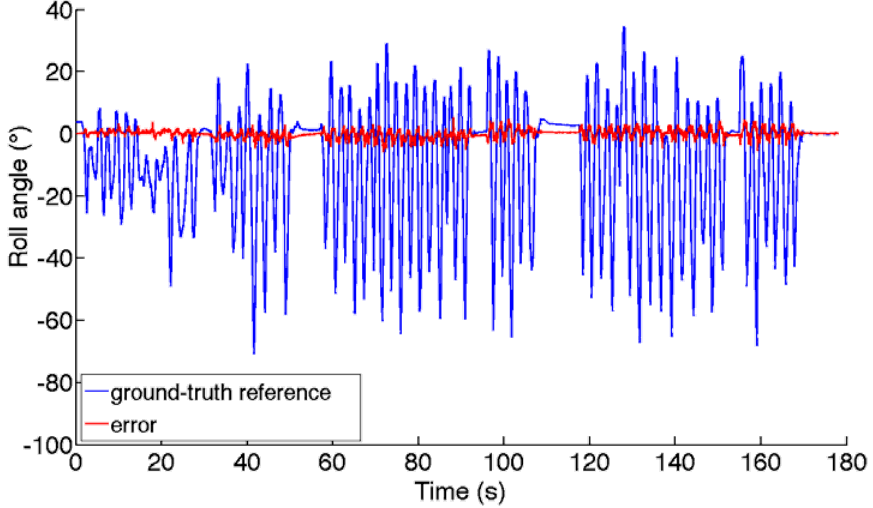
Figure 5. Ground-truth Euler angles and estimation errors incurred by the VSD-EKF (dynamic